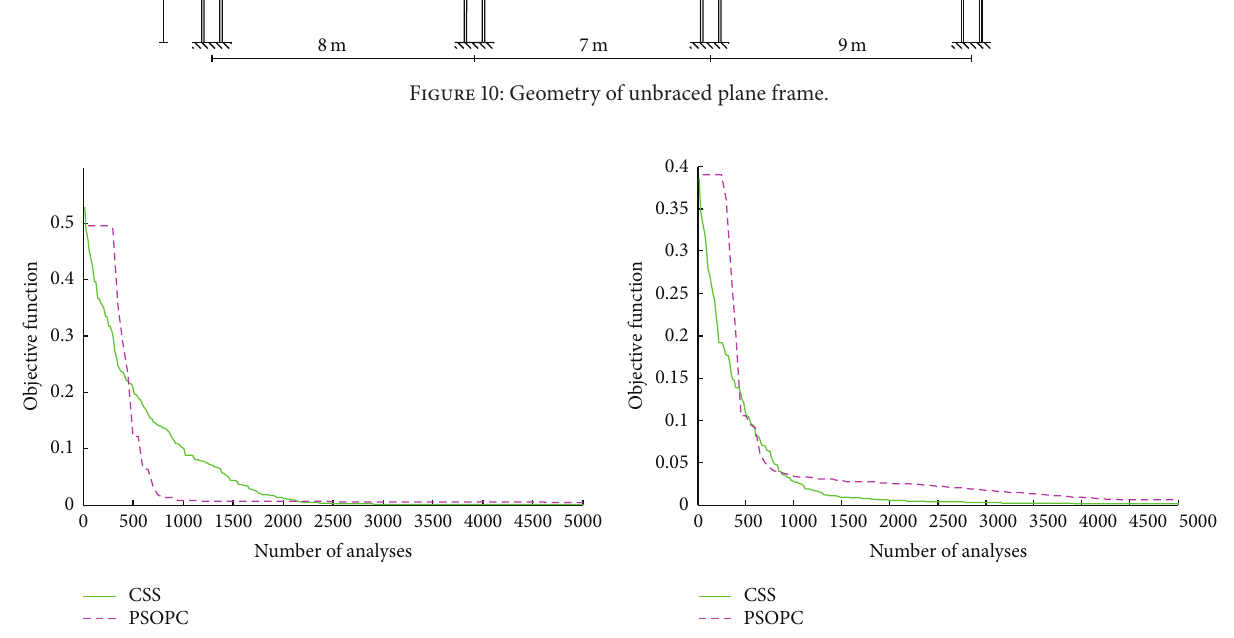
Figure 11: The convergence history of the 39-element frame for the CSS and PSOPC